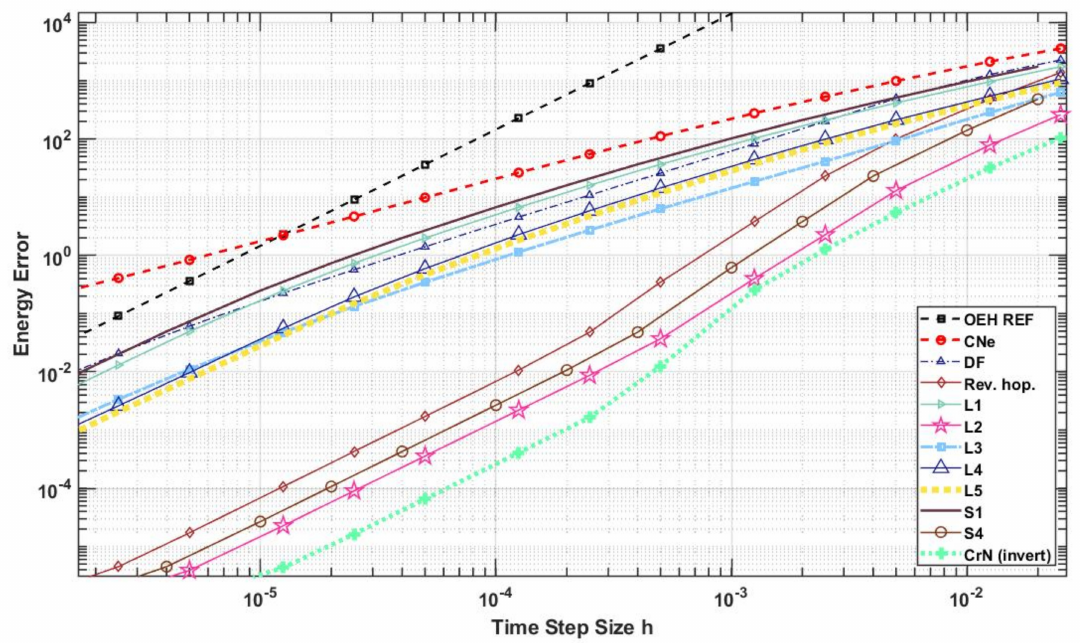
Figure 7. Energy errors as a function of the time step size for the second (very stiff) system, in the case of the original OEH method (OEH REF), the new algorithms L1–L5, and some other methods.